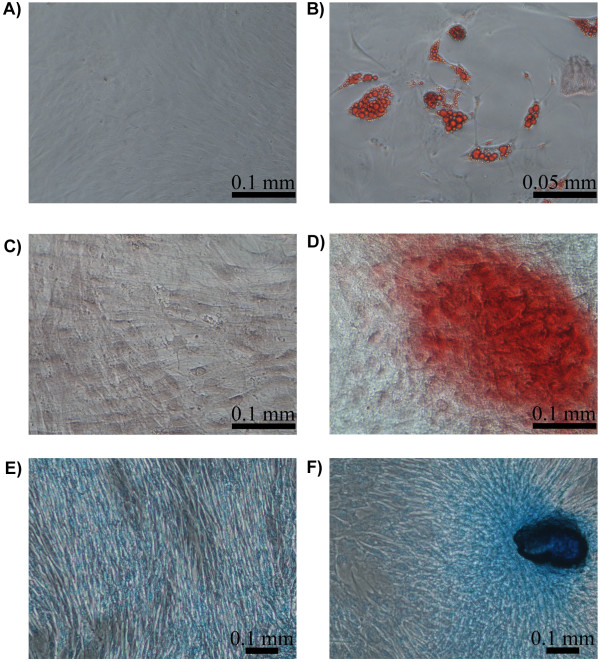
Staining for adipogenic, osteogenic and chondrogenic differentiation of PB-MSCs. Oil red O staining of cells cultured for 15 days in basal (A) and adipogenic differentiation medium (B). Alizarin red staining of cells cultured for 21 days in basal (C) and osteogenic differentiation medium (D). Alcian blue staining of cells cultured for 21 days in basal (E) and chondrogenic medium (F).